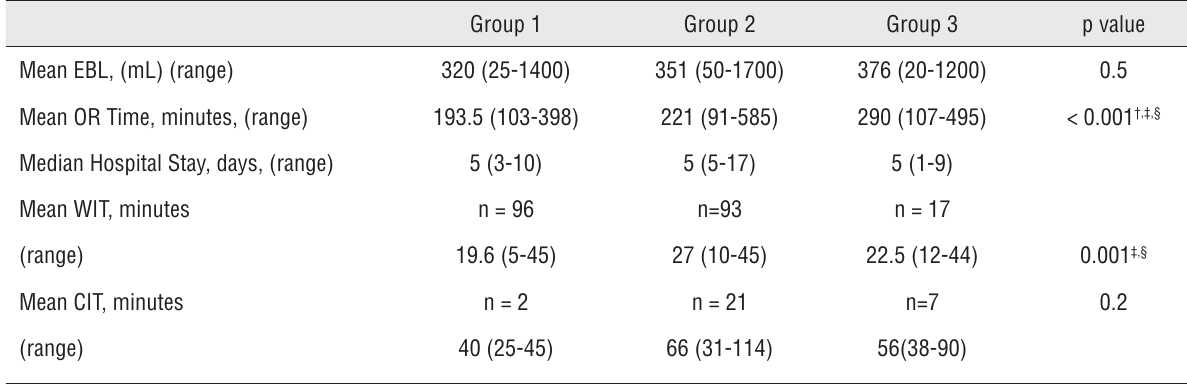
Table 2 - Operative